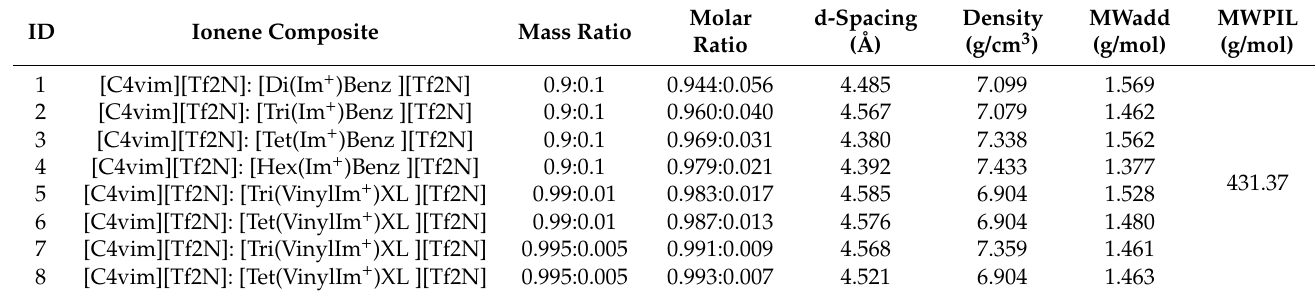
Table 1. Composition and characterization data for each PIL composite.